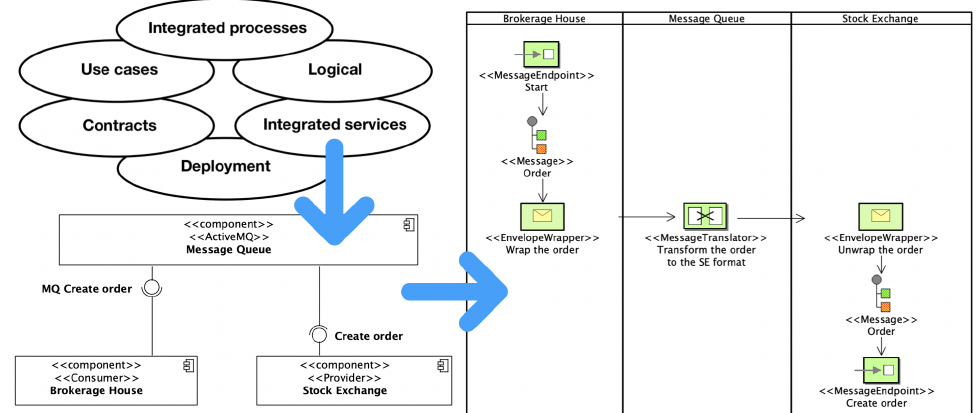
Figure 1. Scheme of using the profile in designing the integration